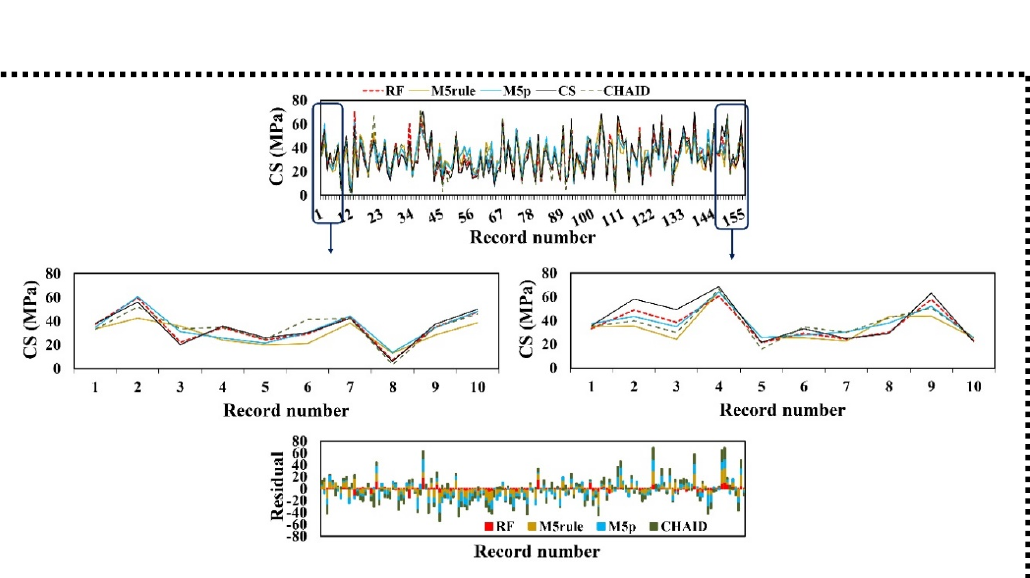
Table 4. Predictive performance of the proposed models for TS prediction.